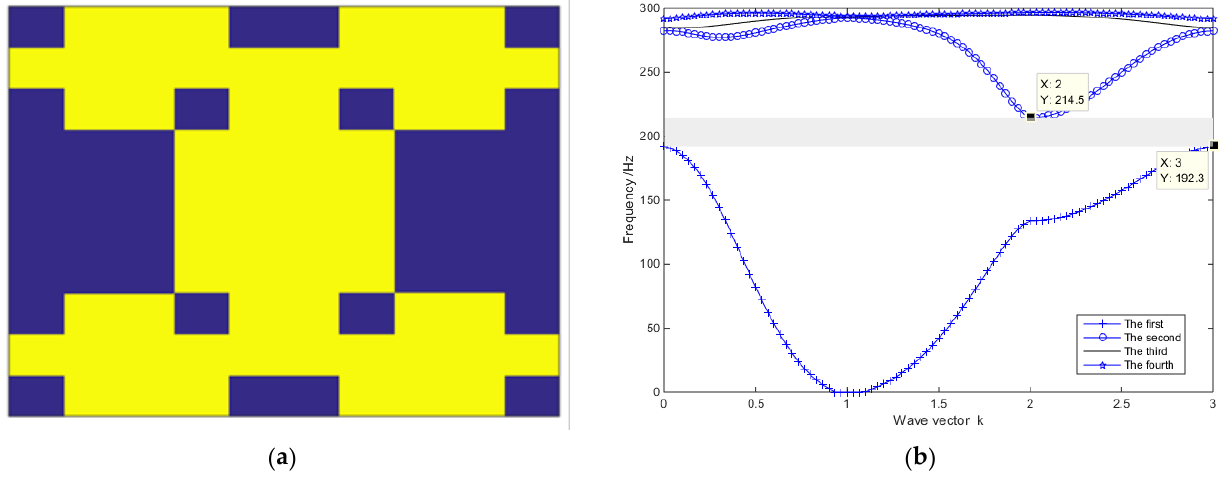
Figure 10. The optimal result under f 0 = 200Hz: ( a ) topology configuration of the unit cell and ( b ) the first four disper- sion curves.